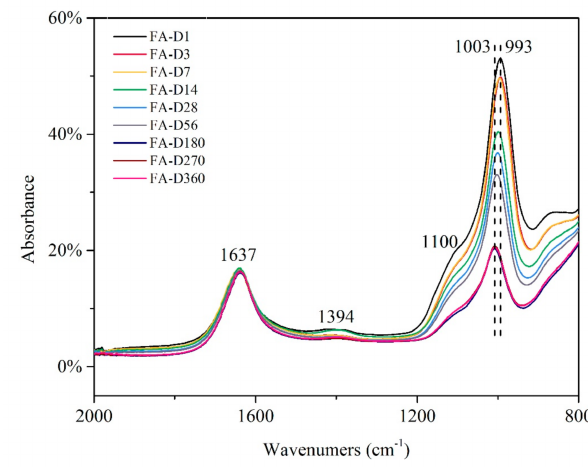
Figure 6. Fourier transform infrared spectra (800–2000 cm − 1 ) of the geopolymer pore solutions at ages between 1 day and 1